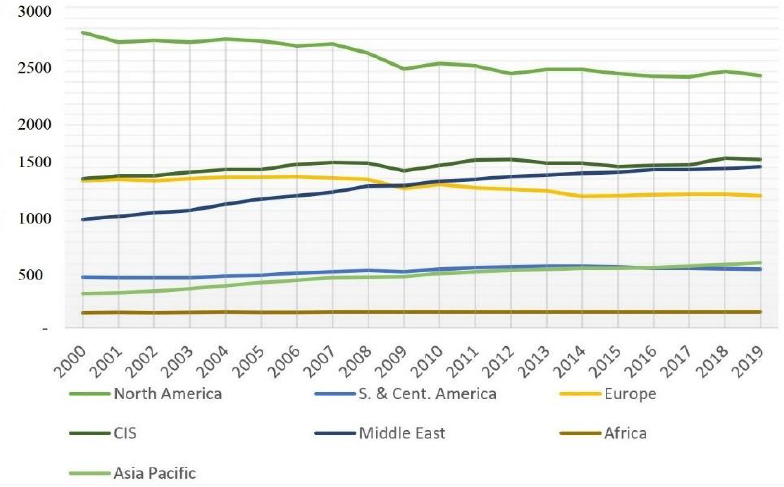
Figure 2. Primary energy consumption per capita (gigajoule per capita). Source: developed by the authors based on statistical data [28].